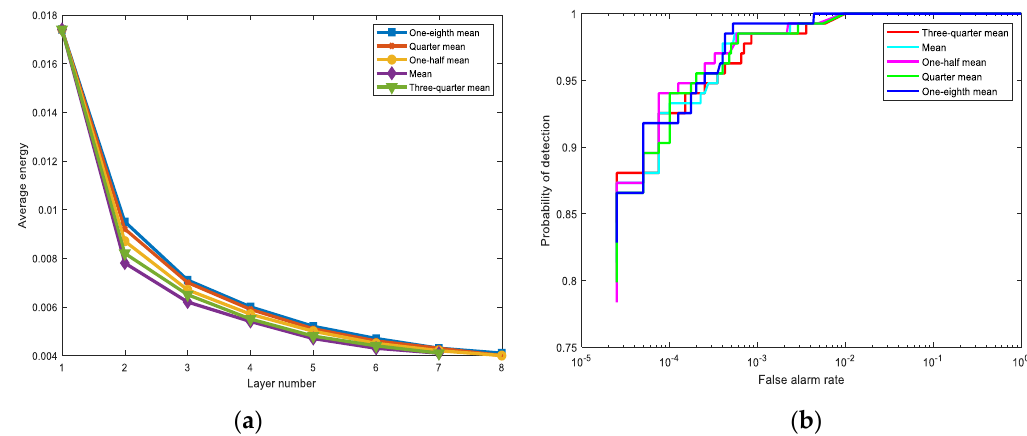
Figure 11. The effects of the different suppression criteria on the San Diego Airport data. The suppression criteria used in the comparative experiments are one-eighth mean, quarter mean, mean, one-half mean, and three-quarter mean. ( a ) The average output energy of different layers for different suppression criteria. ( b ) The ROC curves comparison for different suppression criteria.